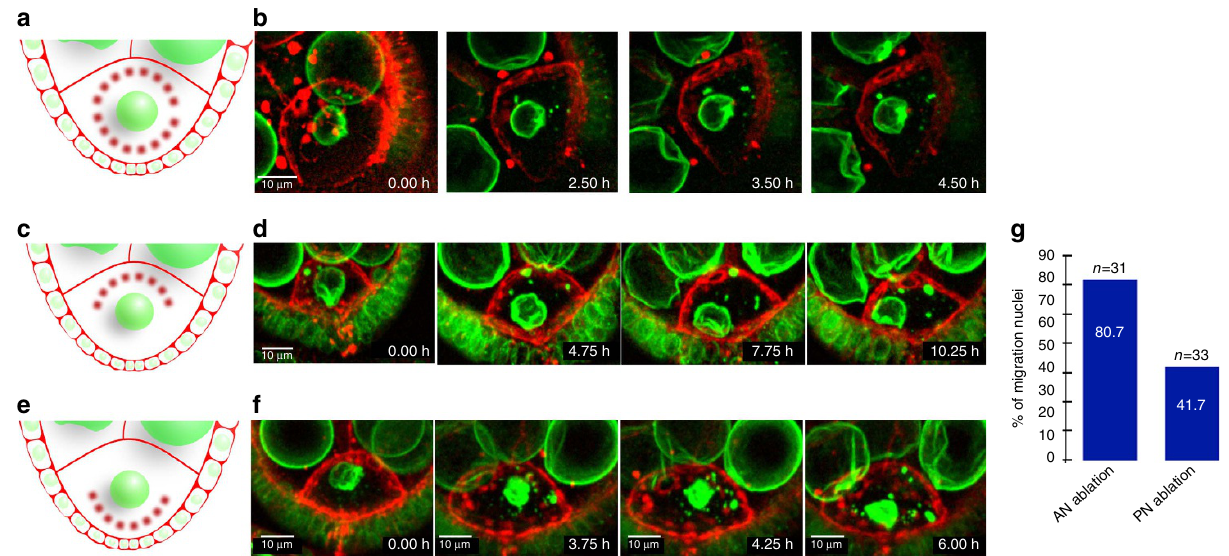
Figure 2 | Nano-ablation-mediated analysis of forces applied onto the nucleus during its migration. Laser ablation experiments were performed on oocytes expressing Fs(2)Ket-GFP to label nuclei (green) and PH PLC- q 1 -RFP to label plasma membranes (red). ( a , c , e ) Schematic representations of the photo-ablated areas (red dots) before nuclear migration. ( b , d , f ) Selected frames extracted from time-lapse movies at the indicated time after ablation. ( b ) Representative example of a nucleus that does not migrate after ablation all around the nucleus ( d ) Representative example of a nucleus migration after nano-ablation performed anteriorly to the nucleus. ( f ) Representative example showing a nucleus that does not migrate after ablation performed posteriorly to the nucleus. ( g ) Bar plots presenting the percentage of oocytes in which nuclear migration is effective after anterior ( n ¼ 31) and posterior ( n ¼ 33)